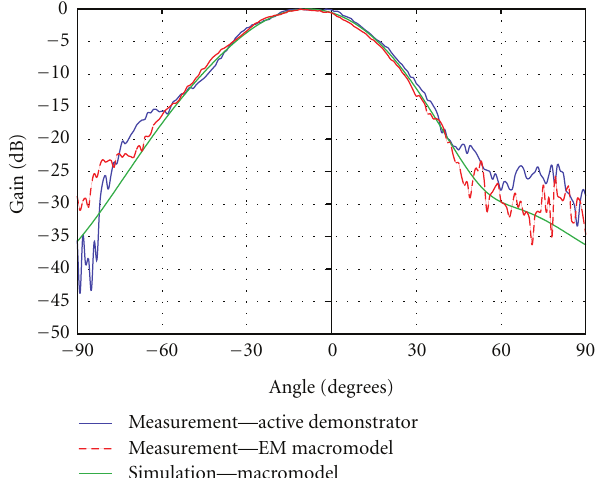
Figure 22: Radiation pattern comparison ( − 10 ◦ ). Active demonstrator measurement (solid line). Measurement without PA (big dashed line). EM macro-model simulation (small dashed line). F 0 = 8 . 2GHz.